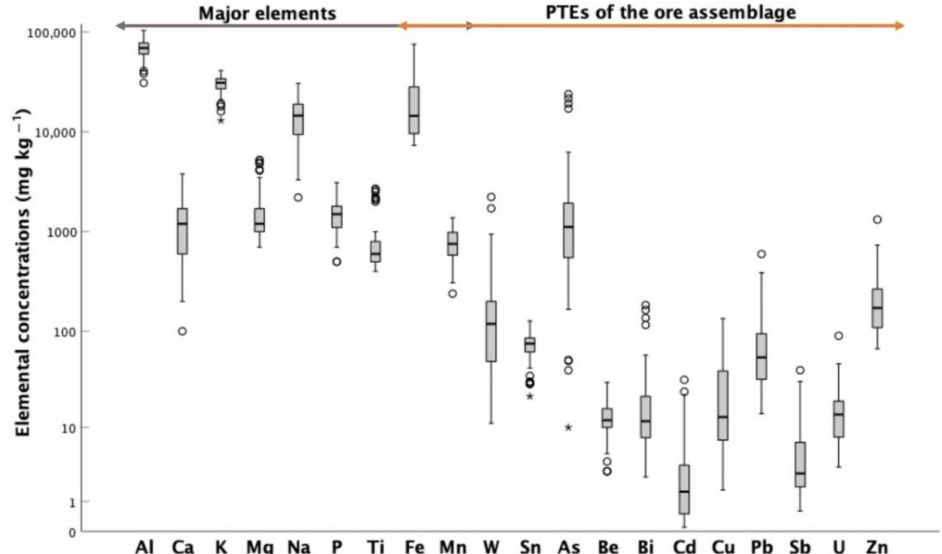
Figure 3. Box plots for major elements and potential toxic elements (PTEs) of the ore assemblage, displaying elemental concentration ranges. Circles and asterisks represent outlier and extreme values,